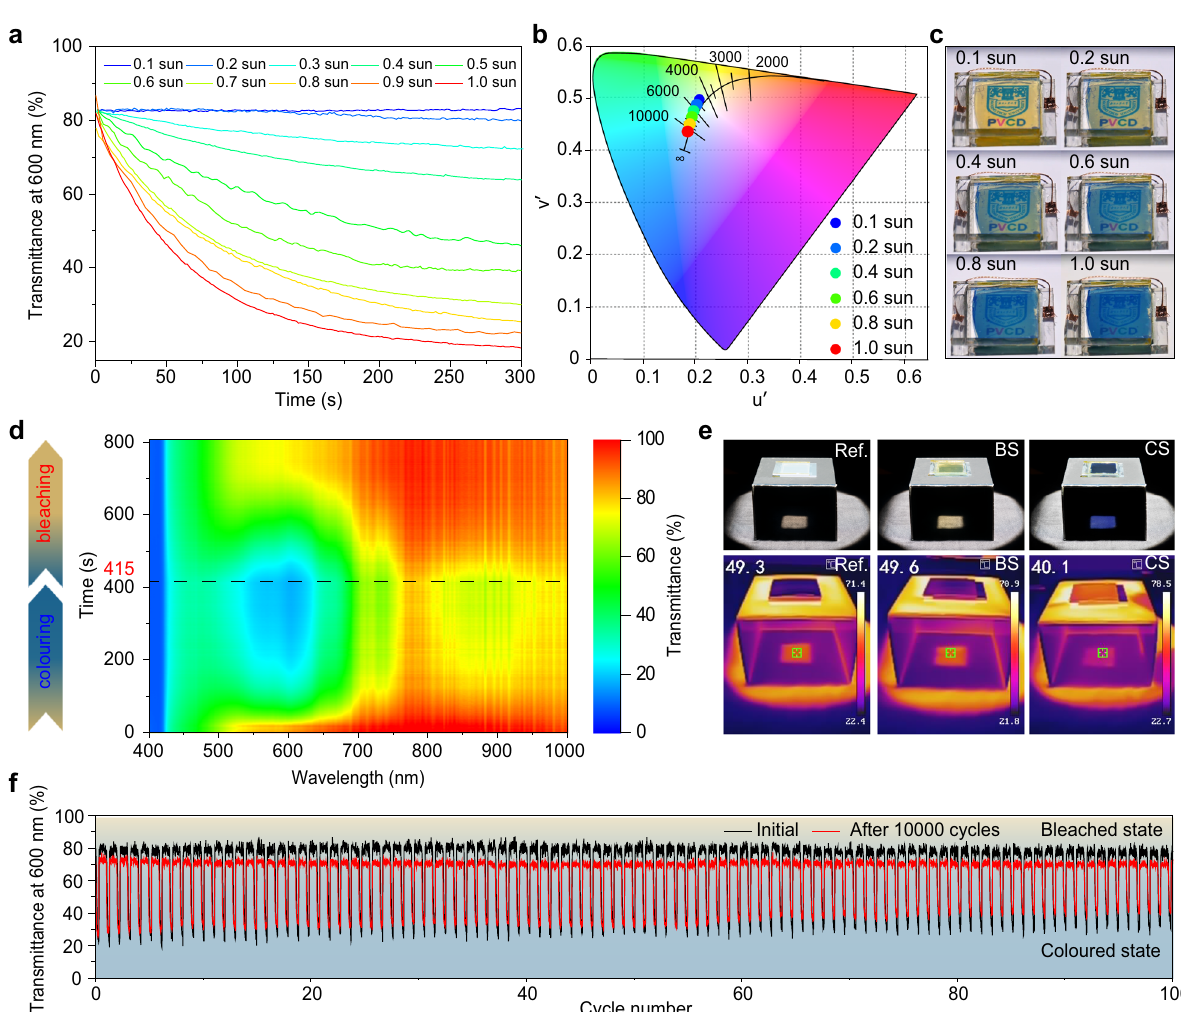
Fig. 3 Photoelectronic performances of solar-adaptable monolithic PVCD based on full-transparent PV. a Real-time transmission ( T %-t) tendencies at 600 nm under different sunlight intensities from 0.1 to 1.0 sun. b CIE 1976 ( u ′ , v ′ ) coordinates and c photographs of PVCD at different sunlight intensities. d Contour mapping diagram of real-time full-wavelength (400 – 1000 nm) transmission spectra under AM 1.5G illumination. External wires of PVCD were connected as close circuit from 0 to 415 s for coloring process, and disconnected as open circuit from 415 to 800 s for bleaching process. e Pro fi le and IR photos of PVCD at BS and CS, two FTO glass substrates used as reference. f Repeatability of PVCD switching between BS and CS by using 395 nm UV-LED as control. In each cycle, PVCD was illuminated for 10 s for coloring process and blocked for 45s for bleaching process, periodically. Black line records the initial 100 cycles, after 1-week continuous service period (>10,000 cycles) by directly connecting external circuit of PVCD in glove box, red line records the fi nal 100